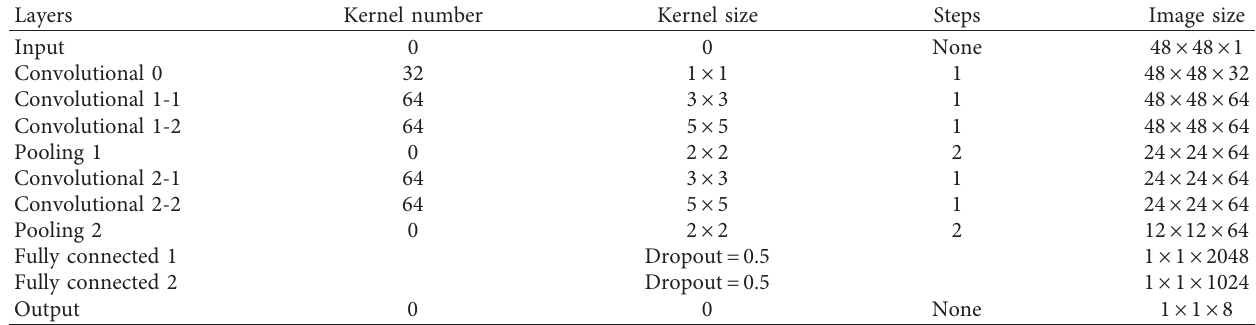
Table 1: The parameters of the applied CNN